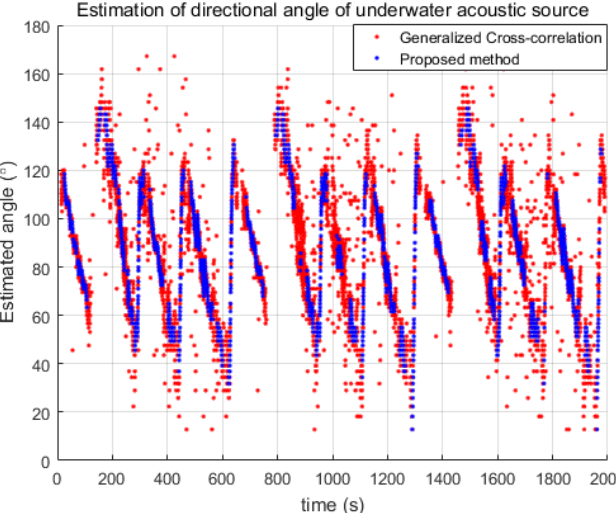
Figure 5. Estimated directional angles using generalized cross correlation and the proposed probabilistic